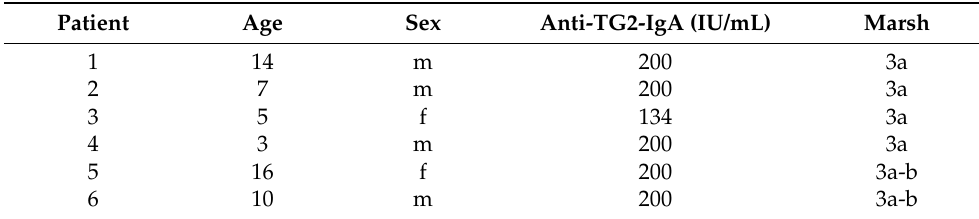
Table 1. Patients’